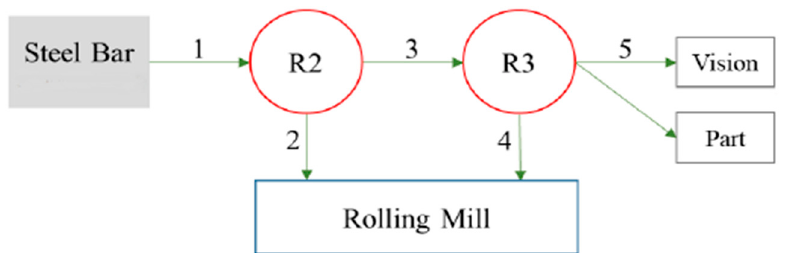
Figure 4. Rolling mill process.